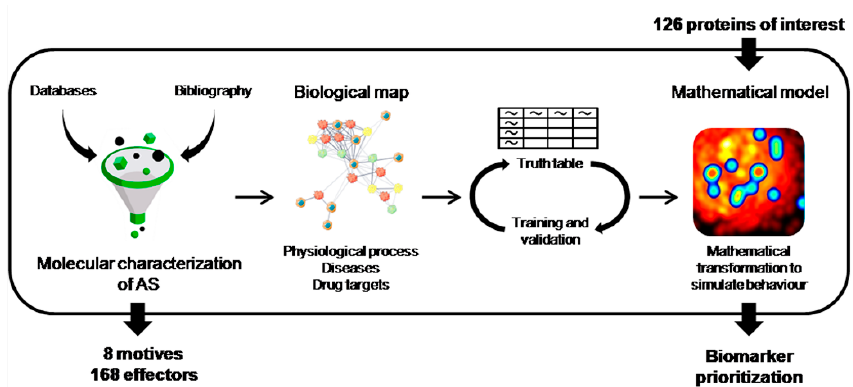
Figure 1. Mathematical model pipeline. Aortic stenosis was defined at molecular level through bibliography and database revision, a biological map was built, and mathematical models were trained. Then, candidate proteins were prioritized according to the functional relationship with the